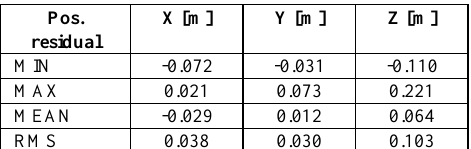
Table 2. Case A: Summary of indirect SO (AT + 3 close GCPs) on 22